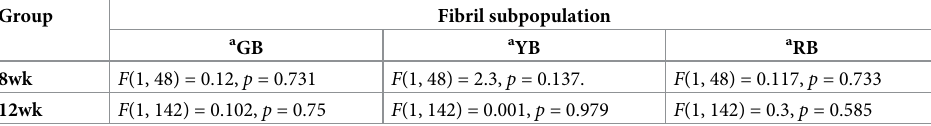
Table 5. Significance of differences between the content of specific groups of collagen fibrils defined by the green (GB), yellow (YB), and red (RB) birefringence. The fibrils were observed in the osteochondral defects in the CA- treated and the ACA-treated rabbits.